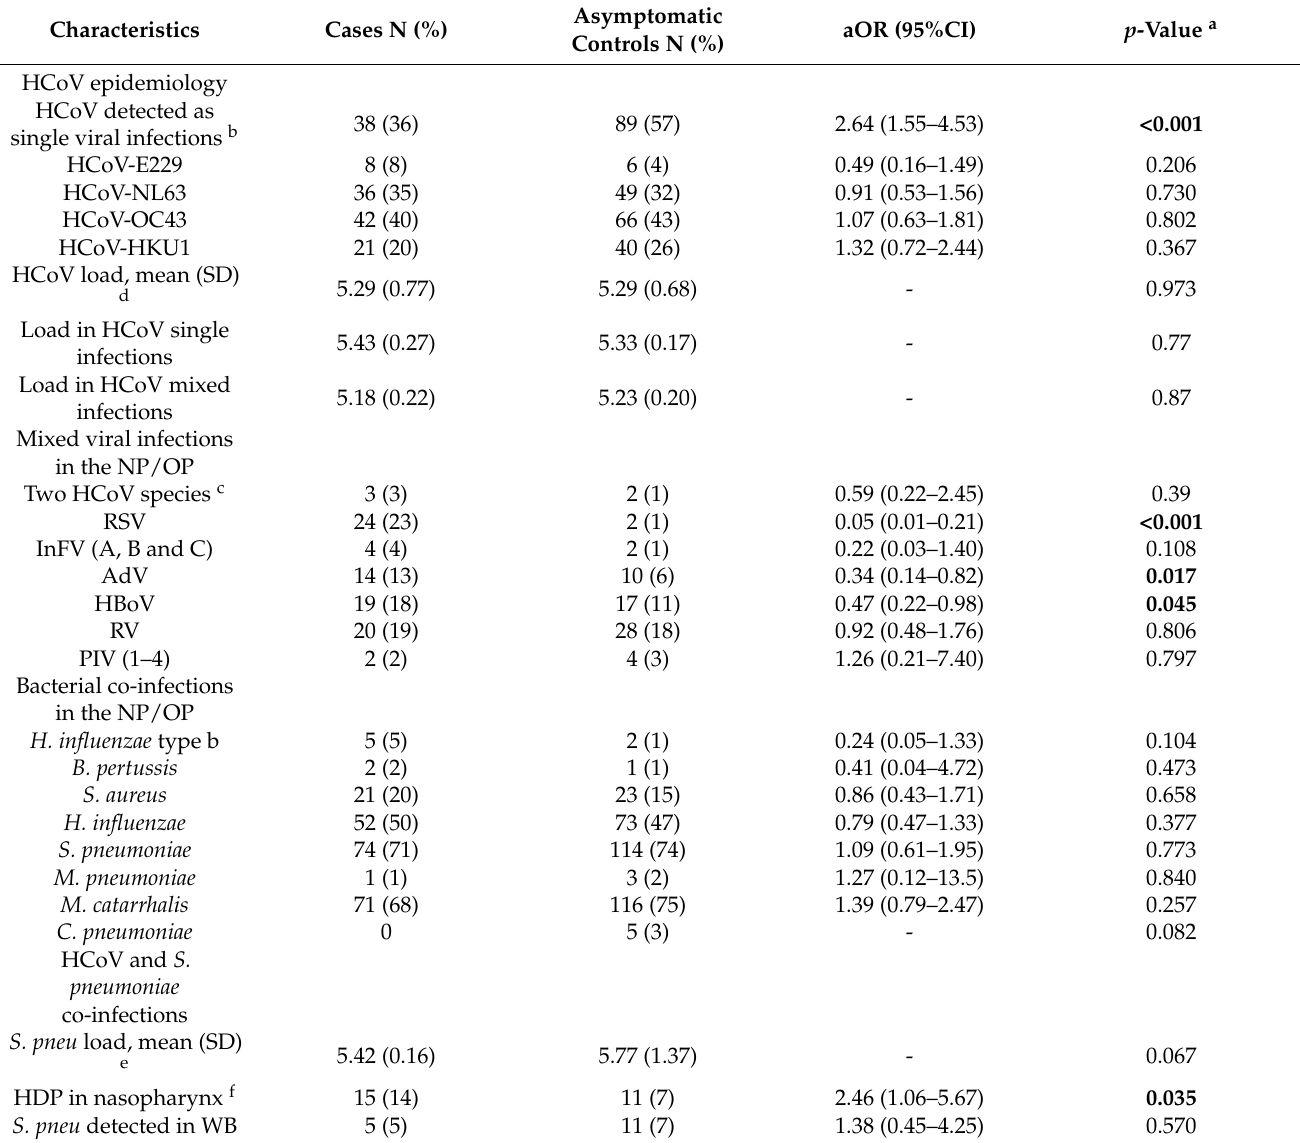
Table 2. HCoV among cases ( n = 104) and asymptomatic controls ( n = 164) at South African and Zambian